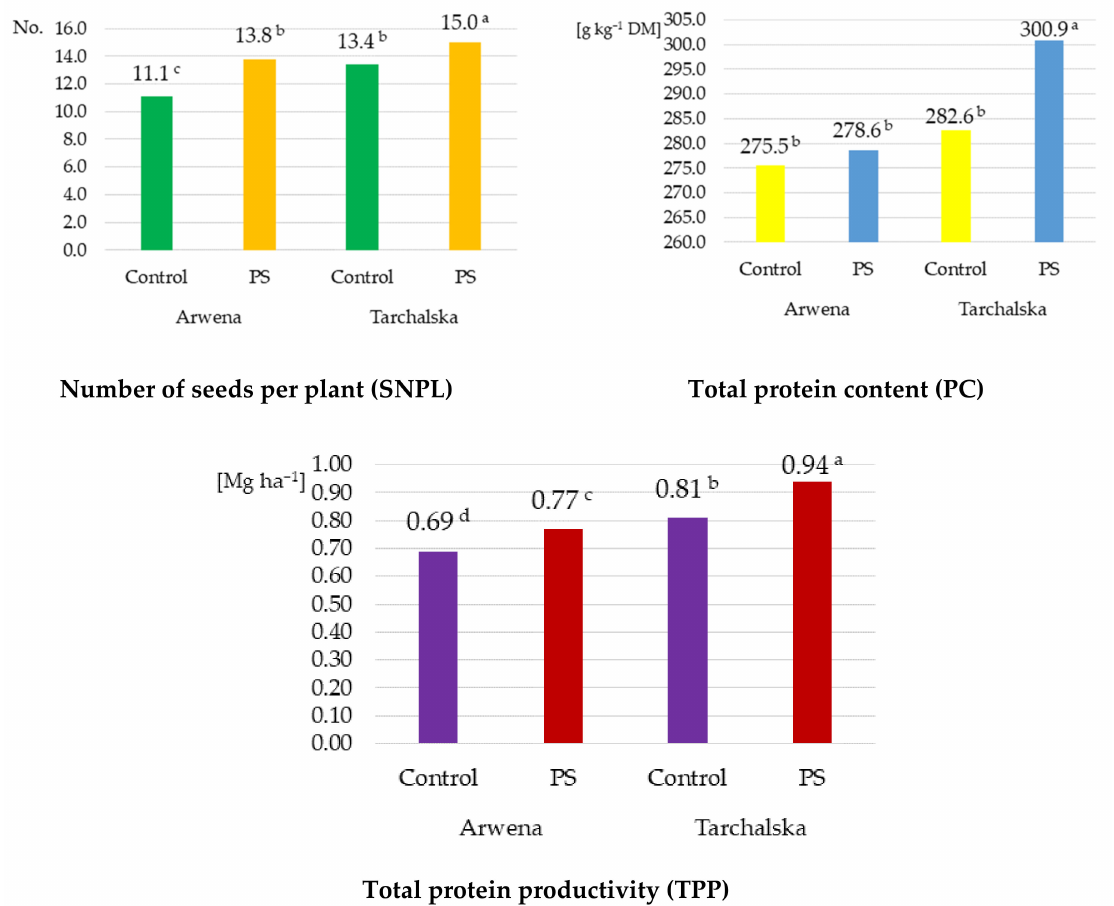
Figure 1. Significant effect of C × A interaction on analysed parameters in 2018. PS—pod sealant application. Different letters indicate a significant difference at p < 0.05 (Tukey’s multiple range